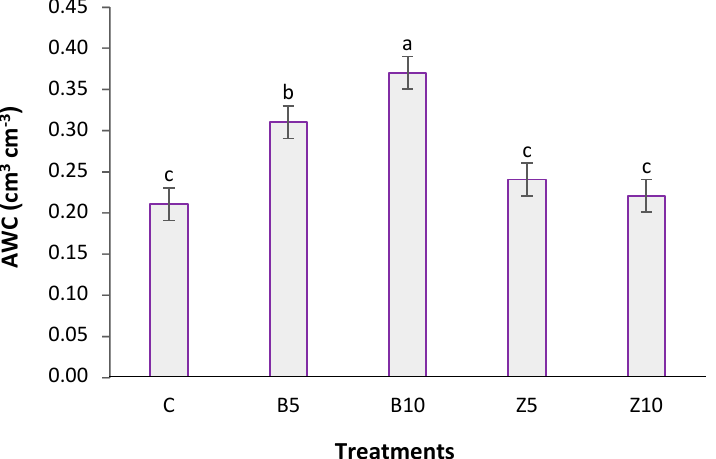
Figure 3. Effect of treatments on soil available water content (AWC). Different lowercase letters indicate significant differences between means ( p < 0.05).